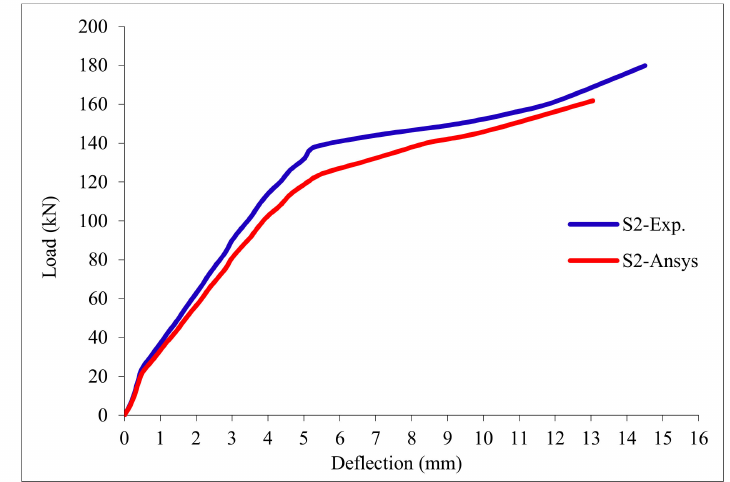
Figure 27. Load deflection curve for control slab S2.